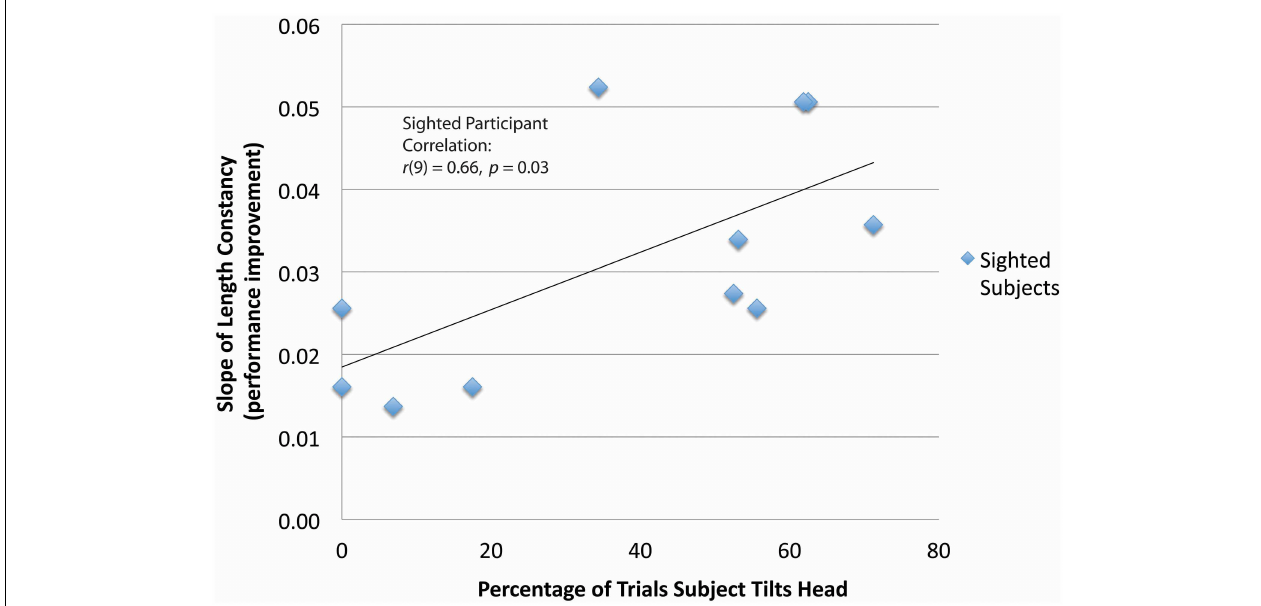
FIGURE 4 | Correlation between head tilt and performance improvement for the length constancy task ( N = 11 ). Significant correlation between head tilt and performance improvement is shown for the length constancy task ( N = 11 ) [ r (9) = 0 . 66 , p = 0 . 03 ]. (Note: See methods